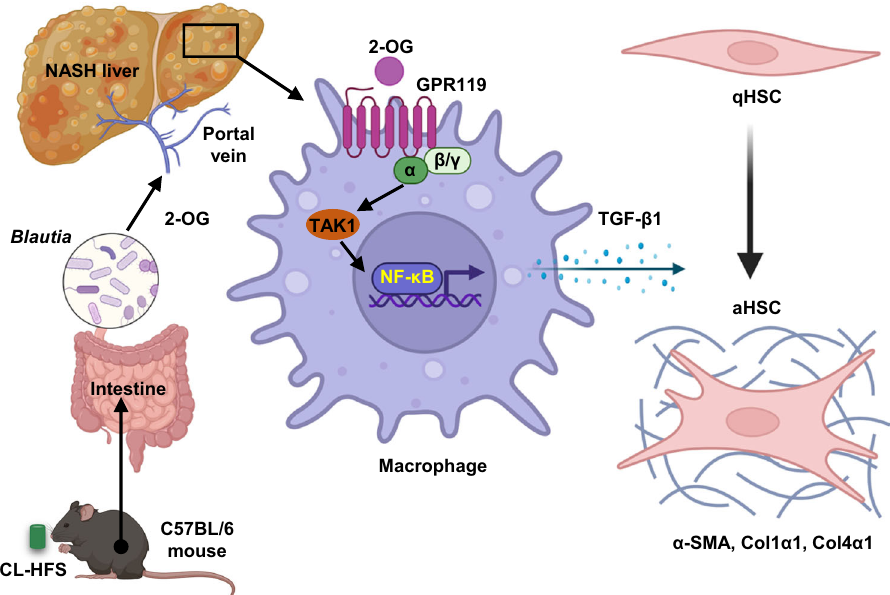
Fig. 8 | Schematic diagram of 2-OG-mediated HSC activation in an M Φ - dependent manner. CL-HFS and Blautia interplay produces 2-OG, which stimu- latesM Φ expressionofTGF- β 1throughGPR119-TAK1-NF- κ Bsignaling.Theresultant